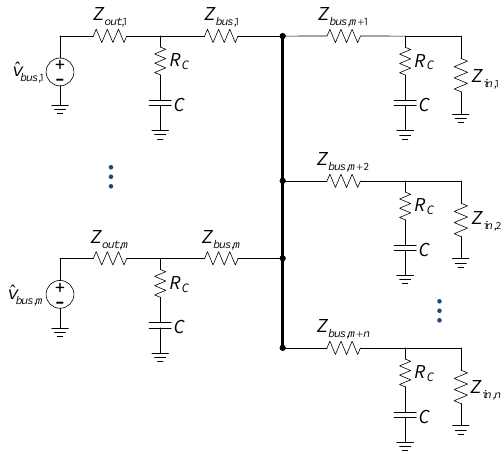
Figure 17. Small-signal equivalent circuit of the standalone DC